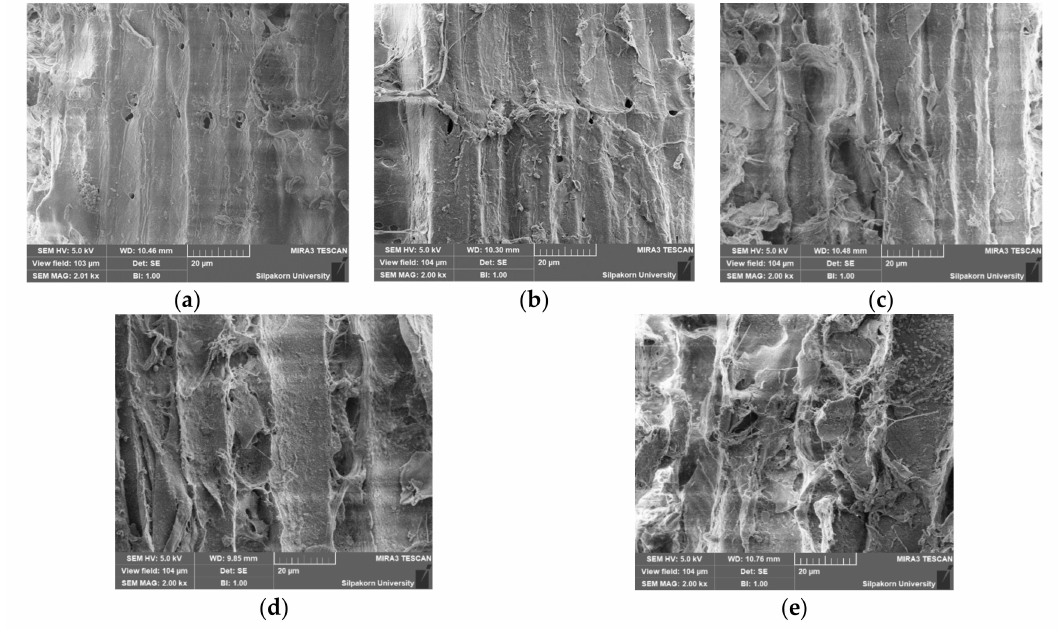
Figure 9. Scanning electron microscopy (SEM) images of torrefied char at temperature of 260 ◦